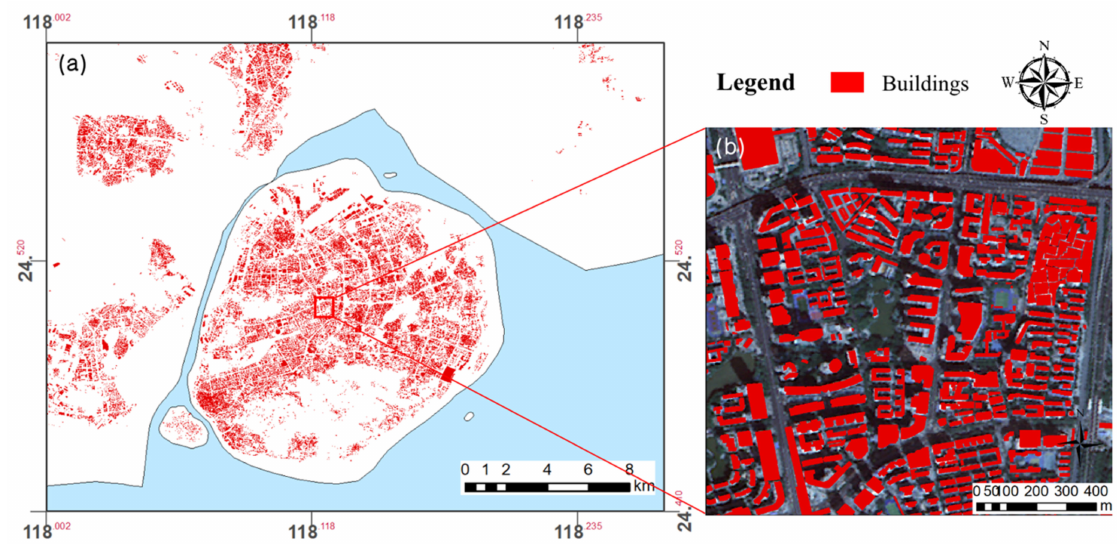
Figure 4. Building data of Xiamen: ( a ) building data in the main urban area; and ( b ) zoomed-in area of the red